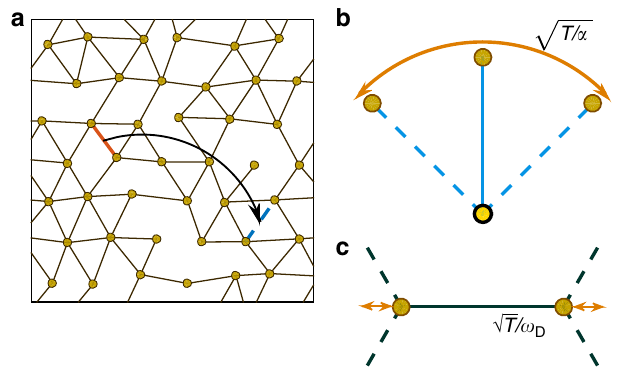
Fig. 2 Illustration of the network model and vibrational space. a The spring connections between perturbed neighbor nodes on triangular lattice, shown as solid lines, de fi ne a network con fi guration. Weak springs (not shown) connect all second neighbors. A new con fi guration is sampled by moving a randomly selected strong spring in red to a random vacant lattice link shown in blue dashed line. Given a con fi guration, thermal vibrations correspond to b a fl oppy mode and c a Debye-frequency mode at